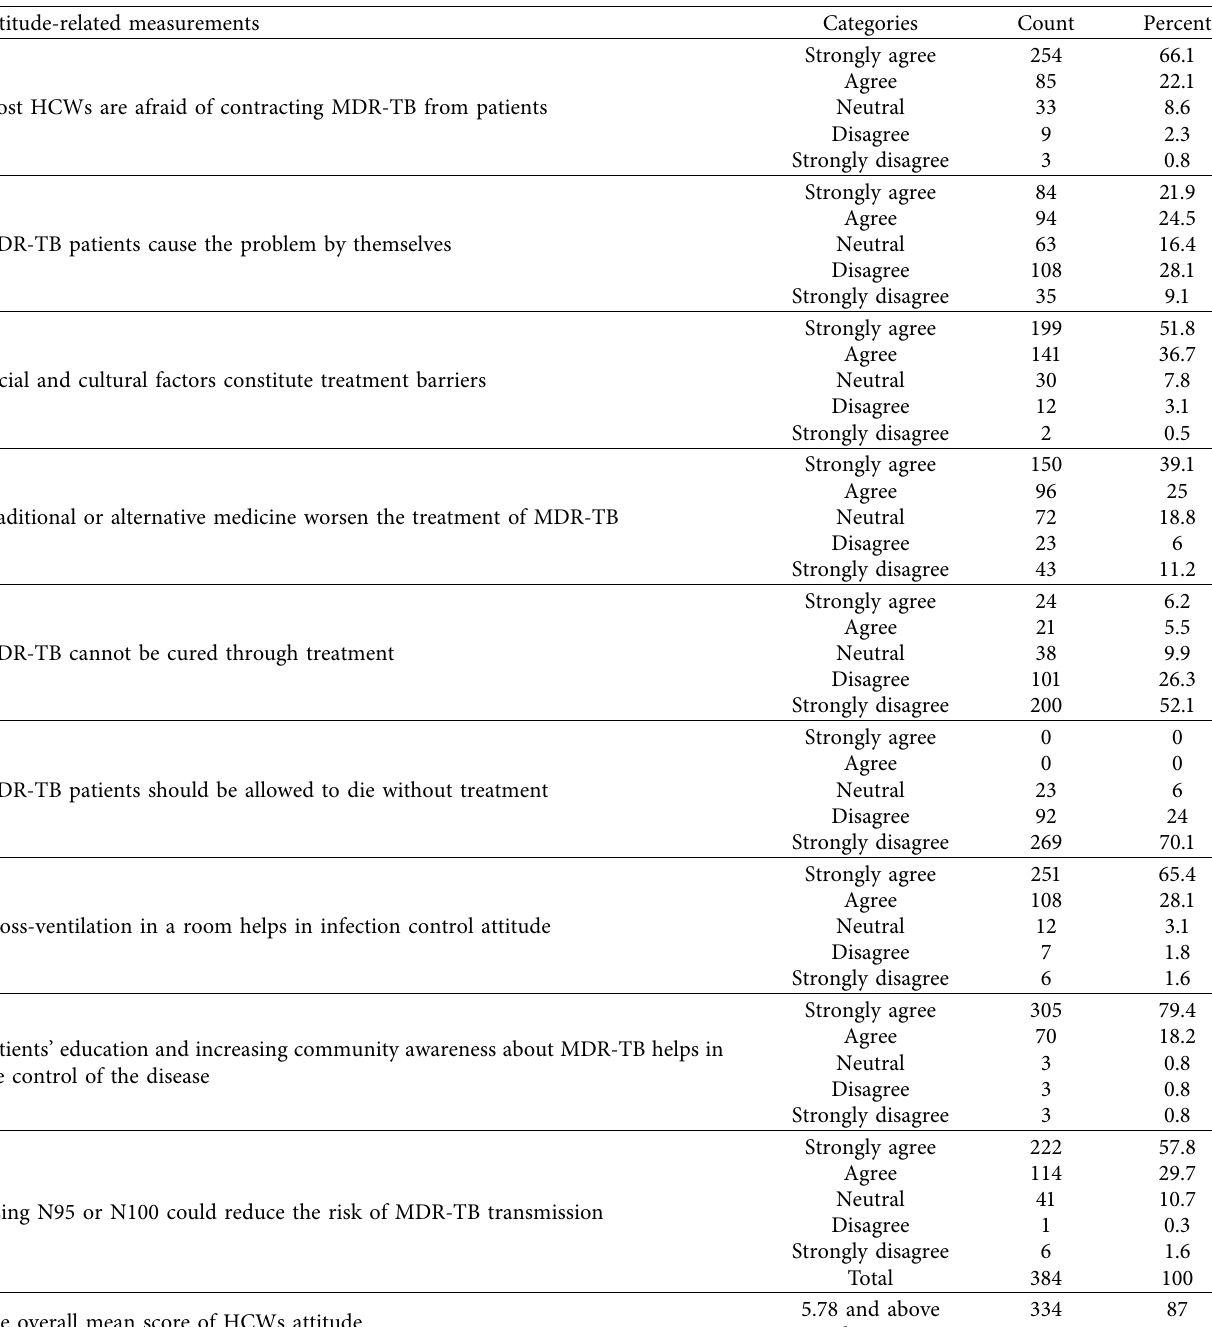
Table 3: Attitude of HCWs about nosocomial MDR-TB-IPC in the two hospitals in Ethiopia. Attitude-related